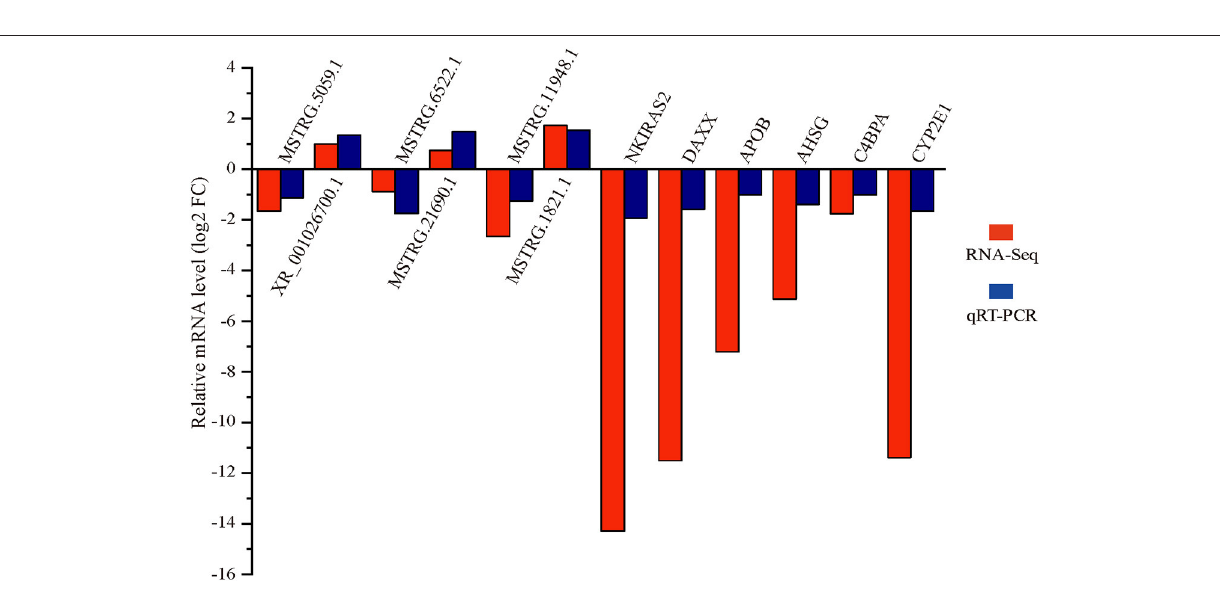
FIGURE 5 | Verification of differentially expressed lncRNAs and mRNAs by